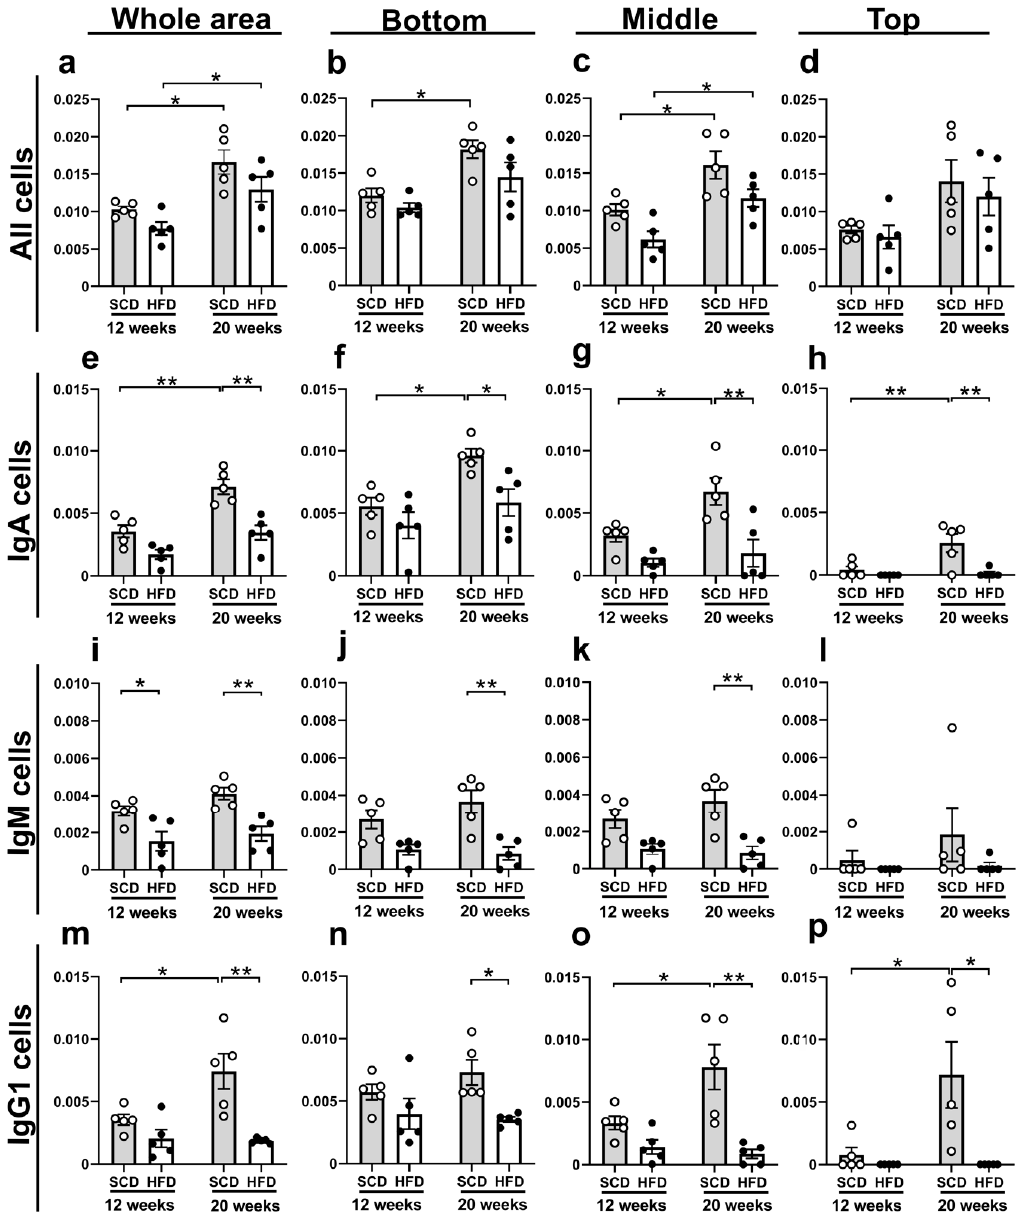
Figure 5. The number of Ig-immunopositive cells in the lamina propria of small intestinal villi. All cells in the whole lamina propria in the small intestinal villi were significantly different between 12-week and 20-week-old SCD-fed mice and between 12-week and 20-week-old HFD-fed mice ( a ). This trend was similar for all cells in the bottom ( b ) and middle ( c ) sections, but not for the top section ( d ). IgA-immunopositive cells in the whole area ( e ) were significantly different between 12- and 20-week-old SCD-fed mice and between SCD and HFD-fed 20-week-old mice. This trend was confirmed in all IgA-immunopositive cell comparisons, in the bottom ( f ), middle ( g ), and top ( h ) sections. IgM-immunopositive cells were significantly different between HFD and SCD-fed 12-week and 20-week-old mice in the whole area ( i ). This trend was similar for in 20-week-old mice on the bottom ( j ) and middle ( k ) sections, but the top ( l ) section did not differ significantly between the diet models. IgG1-immunopositive cells in the whole area ( m ) were significantly different between 12- and 20-week-old SCD-fed mice, and between SCD- and HFD-fed 20-week-old mice. Similarly, a significant difference in the distribution of IgG1-immunopositive cells was found in the middle ( o ) and top ( p ) sections. However, in the bottom section, a significant difference was found only between 20-week-old SCD-fed and HFD-fed mice ( n ). For the sake of comparison, we defined the central part of the villi as per a method of villi division detailed in the Quantitative analysis sub-section of the Materials and Methods. The same number of animals was used in all groups ( n = 5 per group). Results are presented as the mean ± SEM of the number of cells per µ m 2 . * p < 0.05, ** p < 0.01 (Two-way ANOVA with Holm-Š í d á k’s post hoc